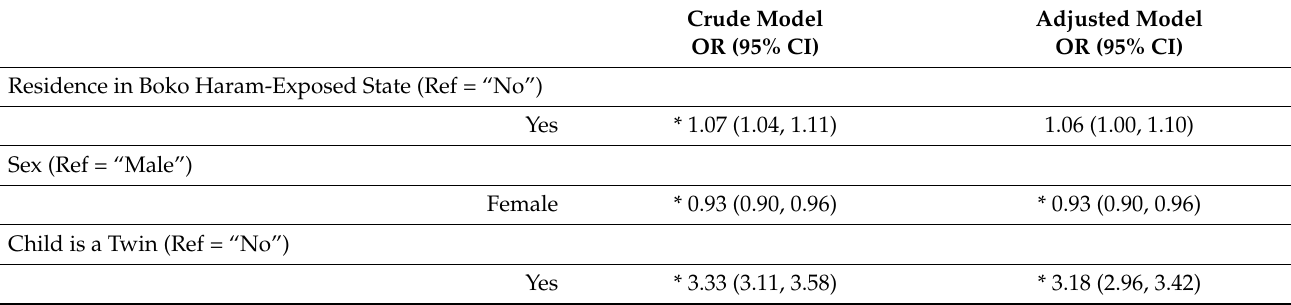
Table 2. Crude and Adjusted Estimates of Predictor Variables on Child